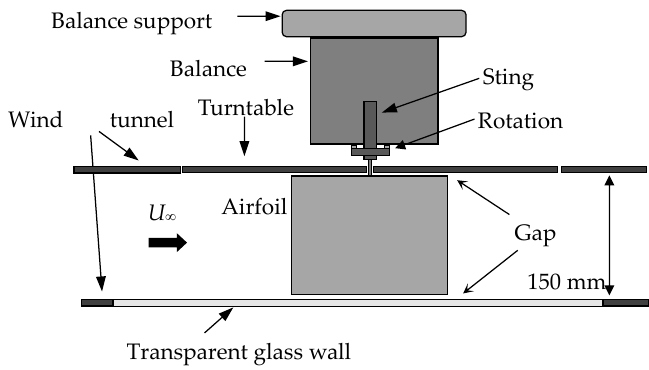
Figure 2. Experimental setting in the test section.